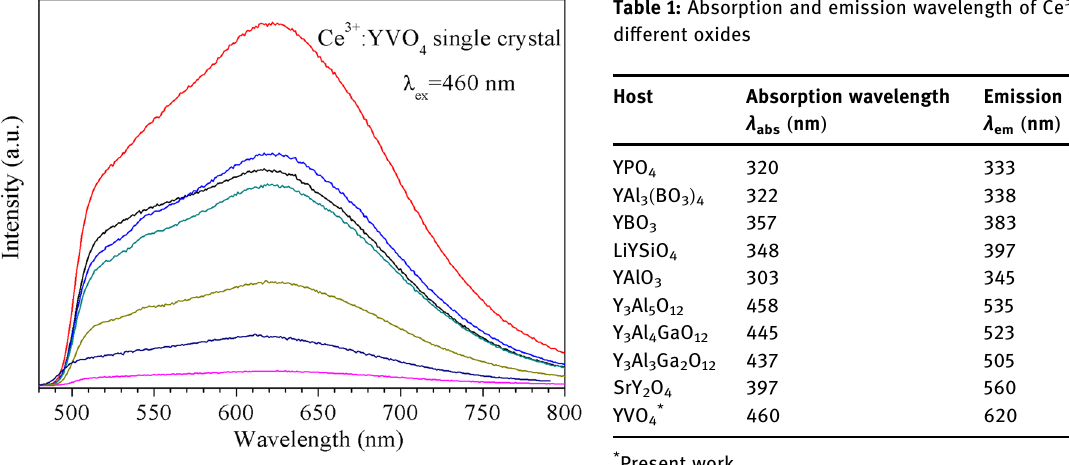
Figure 4: Visible emission spectra of Ce 3 + - doped YVO 4 crystals with various doping concentrations. The excitation wavelength is 460 nm corresponding to the 2 F 5/2 → 2 D 3/2 absorption transition of Ce 3 + ions.